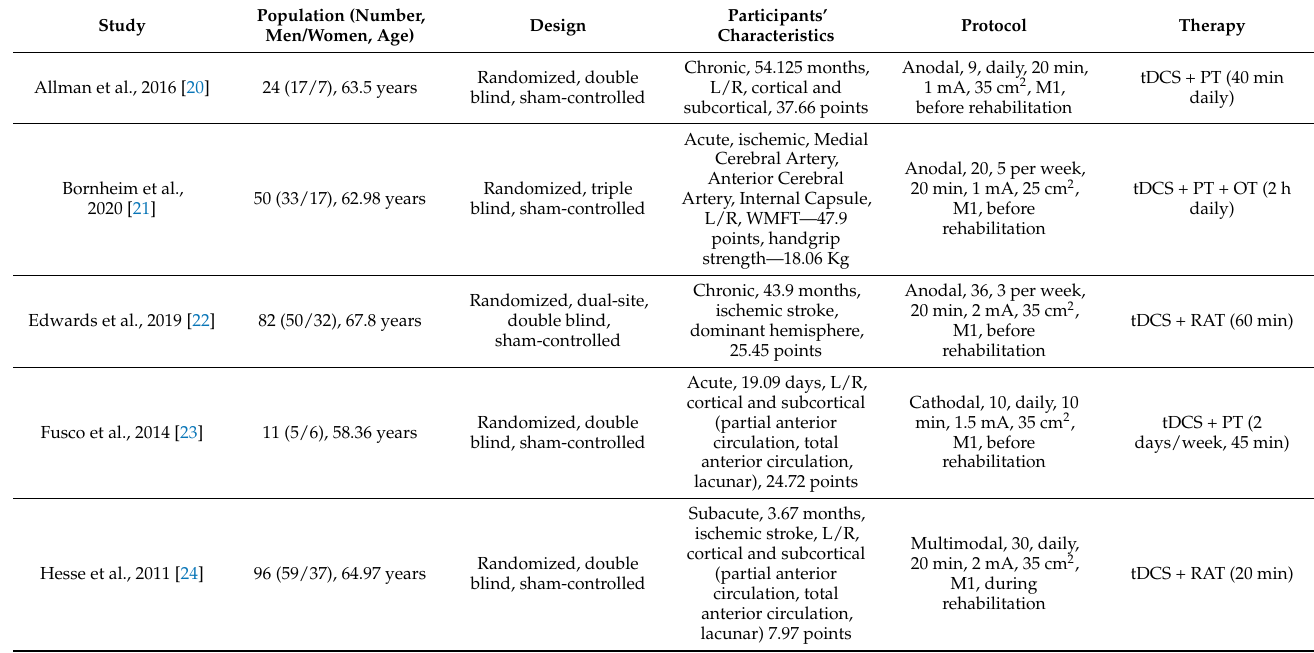
Table 1. Subjects and intervention characteristics.